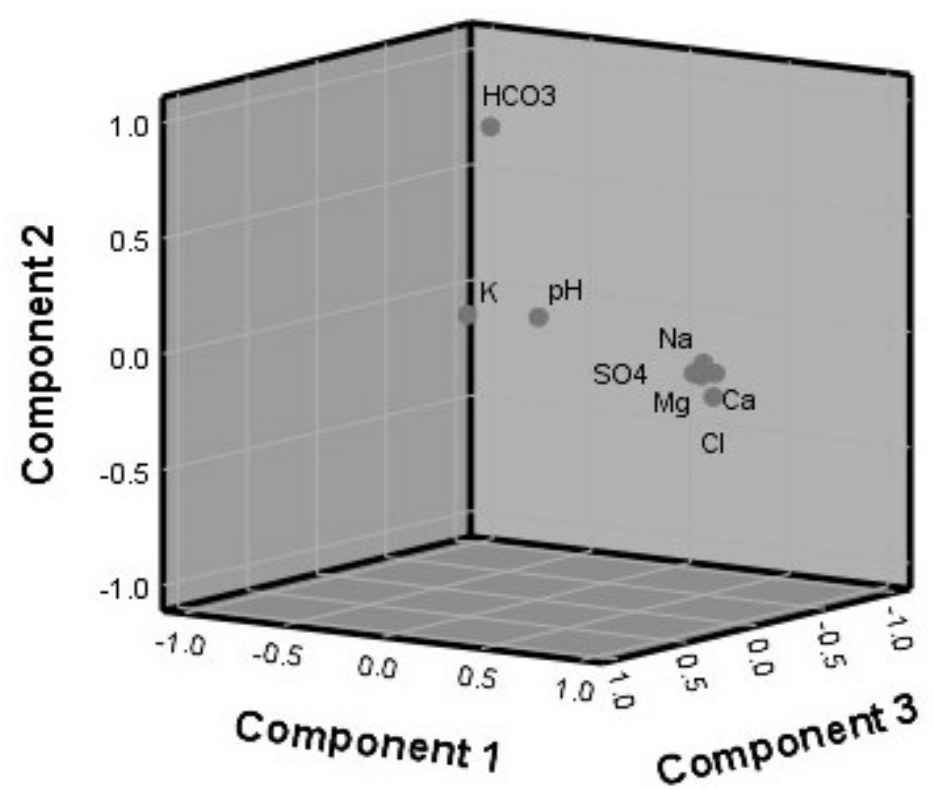
Figure 8. Component plot in the rotated space (PCA).